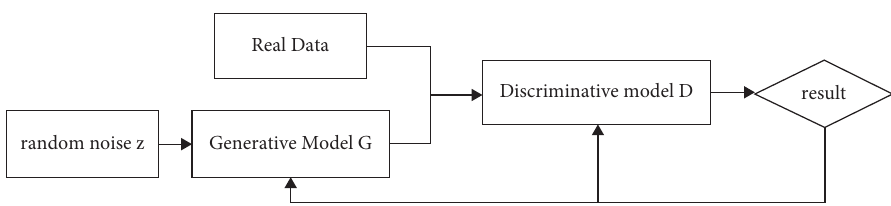
Figure 4: The GAN network model